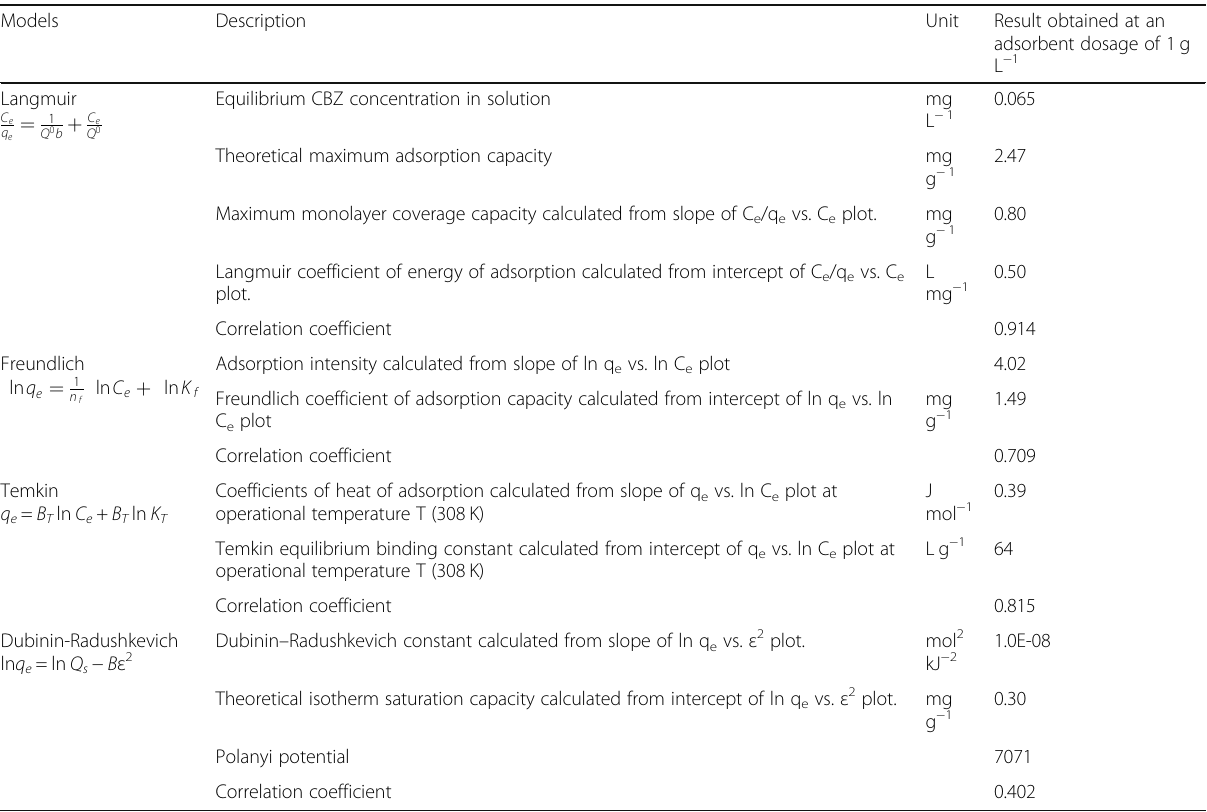
Table 2 Isotherm parameters for Carbamazepine (CBZ) adsorption by graphene oxide nanoplatelet (GONP)